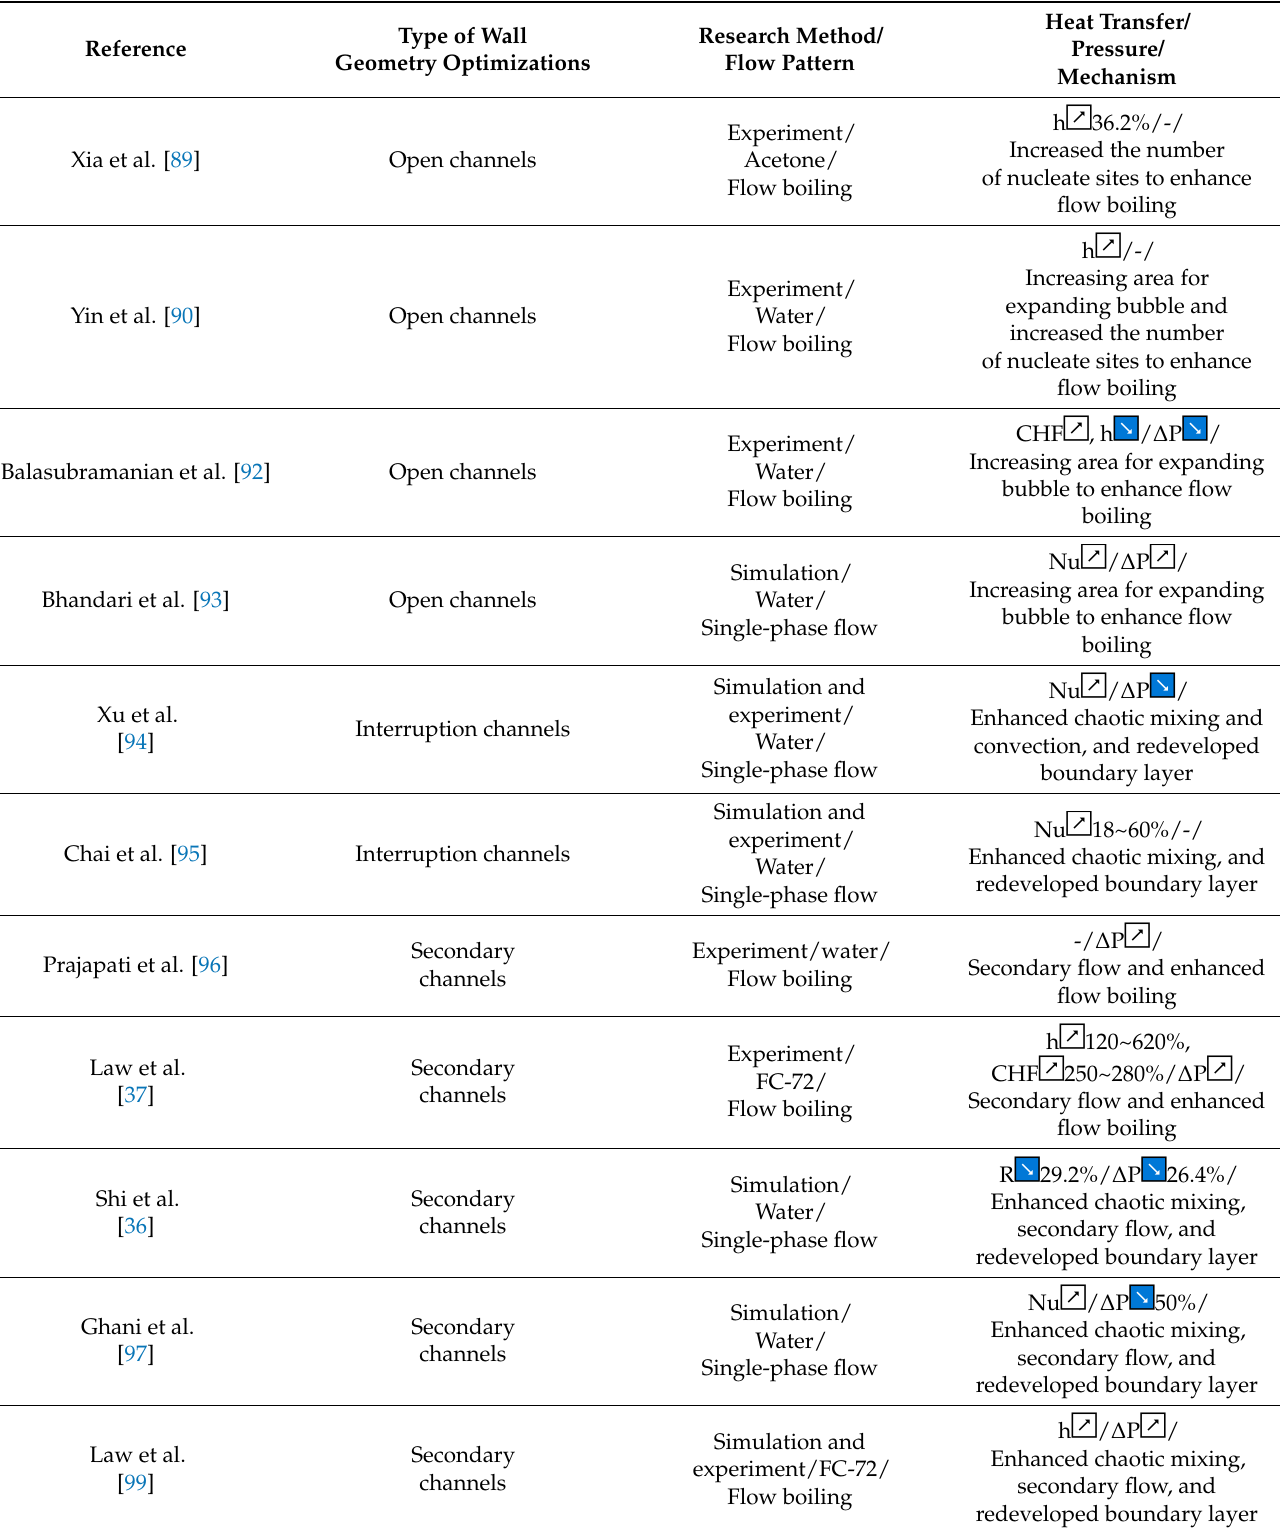
Table 3. Selected studies of geometric optimization on sidewall and bottom wall of the microchan- Table 4. Selected studies of geometric optimization on open, interruption, and secondary channel on nel on heat transfer. heat transfer.